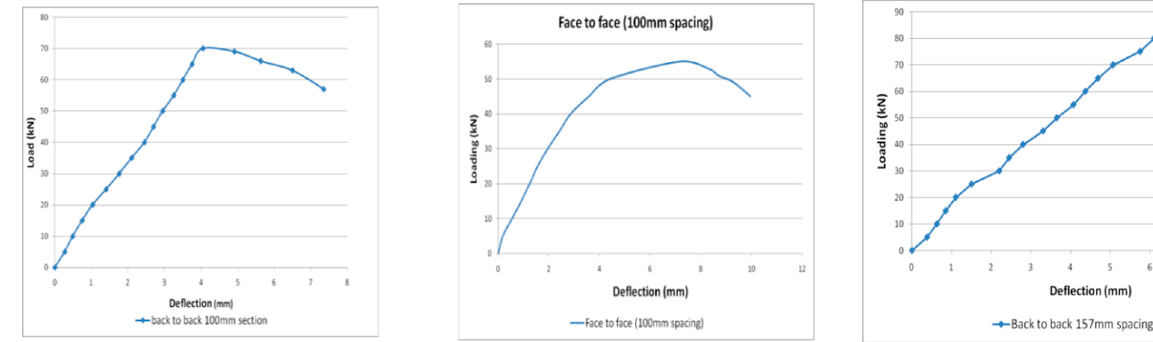
Figure 13. Load vs. deflection behavior.